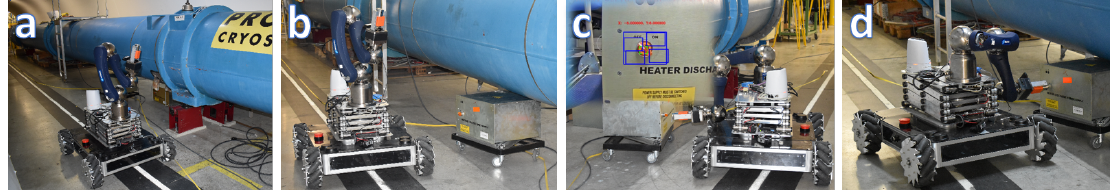
Figure 9. Task sequence carried out by CERNBot2: ( a ) target detection through a Pan–Tilt–Zoom (PTZ) camera, ( b ) approaching to the target, ( c ) depth estimation ( d ) switch